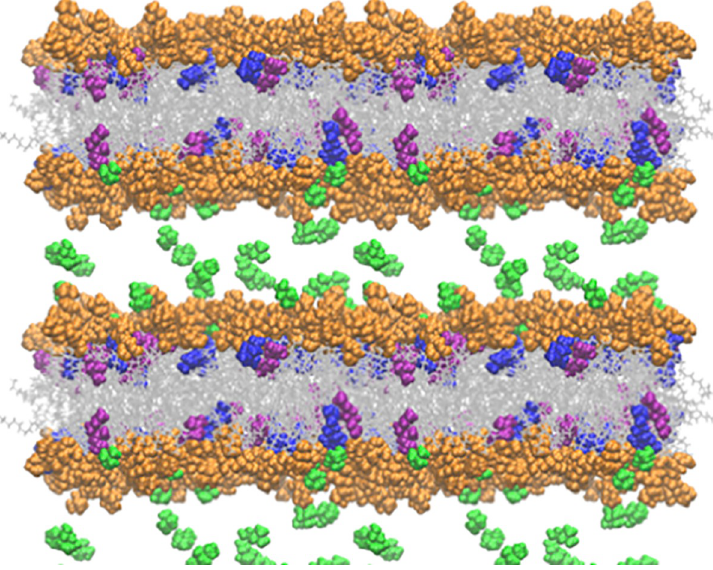
Fig 5. Static representation of model POPE membranes in the presence of CAGE. The lipid head groups are depicted in orange, the lipid tails in grey, cholinium cation in green, geranate in purple, and geranic acid in blue. Water molecules are omitted for clarity. Several periodic images are shown to make the long ranged structure clearer.